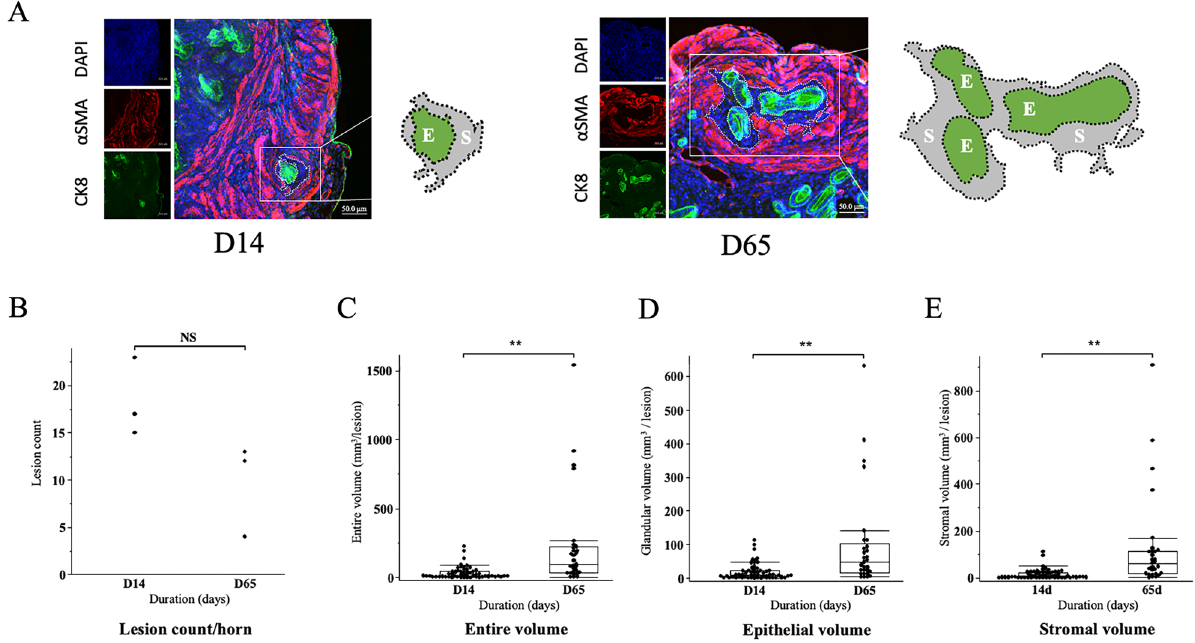
Figure 2. ( A ) A representative immunofluorescence image of the adenomyosis lesion (×400) on the 14th postoperative day (D14) and the 65th postoperative day (D65) with cytokeratin 8 (CK8) (red) and alpha smooth muscle actin (α SMA) (green). In the illustration, the area highlighted in green (E) is the area of the epithelium of the adenomyosis lesion stained with CK8, and the area highlighted in gray (S) is the area of the stroma of the lesion, which is not stained with either aSMA or CK8. ( B ) A scatter plot for the adenomyosis lesion count per horn. Lesion count per horn was compared between the D14 and D65. The count was not significantly different between the groups. ( C–E) A box and whisker graph for the adenomyosis lesion volume. The lesion volume of the entire ( C ), epithelial ( D ), and stromal ( E ) area was compared between D14 and D65. The cross-sectional area of the lesion was measured by tracing the innermost line of the smooth muscle that was identified by positive staining with αSMA and using it as the outermost line of the lesion. The cross-sectional area of the epithelial part of the lesion was measured by tracing the epithelium, with positive CK8 staining, within the adenomyosis lesion. The cross-sectional area of the stromal part of the lesion was calculated by subtracting the area of the epithelial part from the area of the entire lesion. The volumes of each lesion were calculated as the sum of cross-sectional areas multiplied by the inter-slide spacing. The volume was significantly larger in D65 than in D14 (p < 0.0001). Box: 25–75%, whisker: 10–90%, midline: median, NS not significantly different **p <